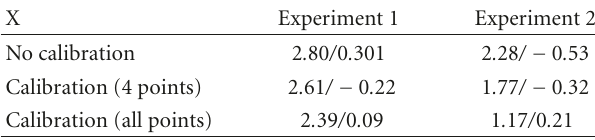
Table 1: Measurement campaigns.